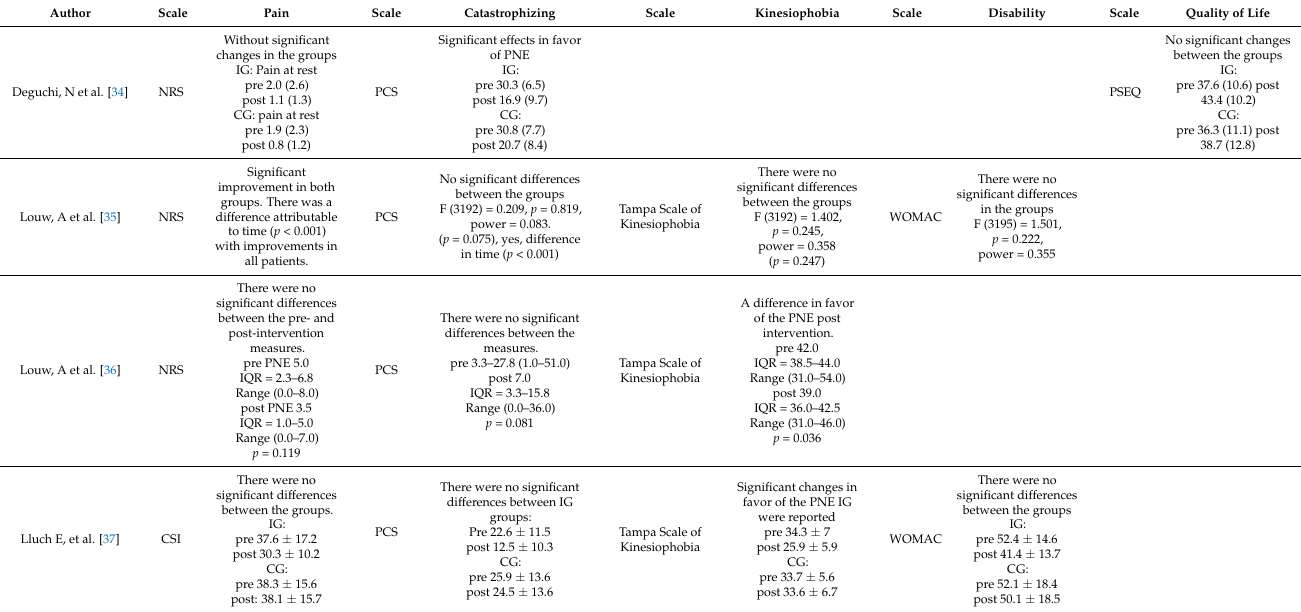
Figure 3. Risk of bias PEDro scale. Source: Own source with Revman Manager 5.3. Table 2 shows the main results of the measurements pain, catastrophizing, kinesiopho- bia, disability, and quality of life found in the review. A meta-analysis of the data was not possible because of heterogeneity and a lack of unanimity in the interventions presented. Table 2. Results of the studies for pain, catastrophizing, kinesiophobia, disability, quality of